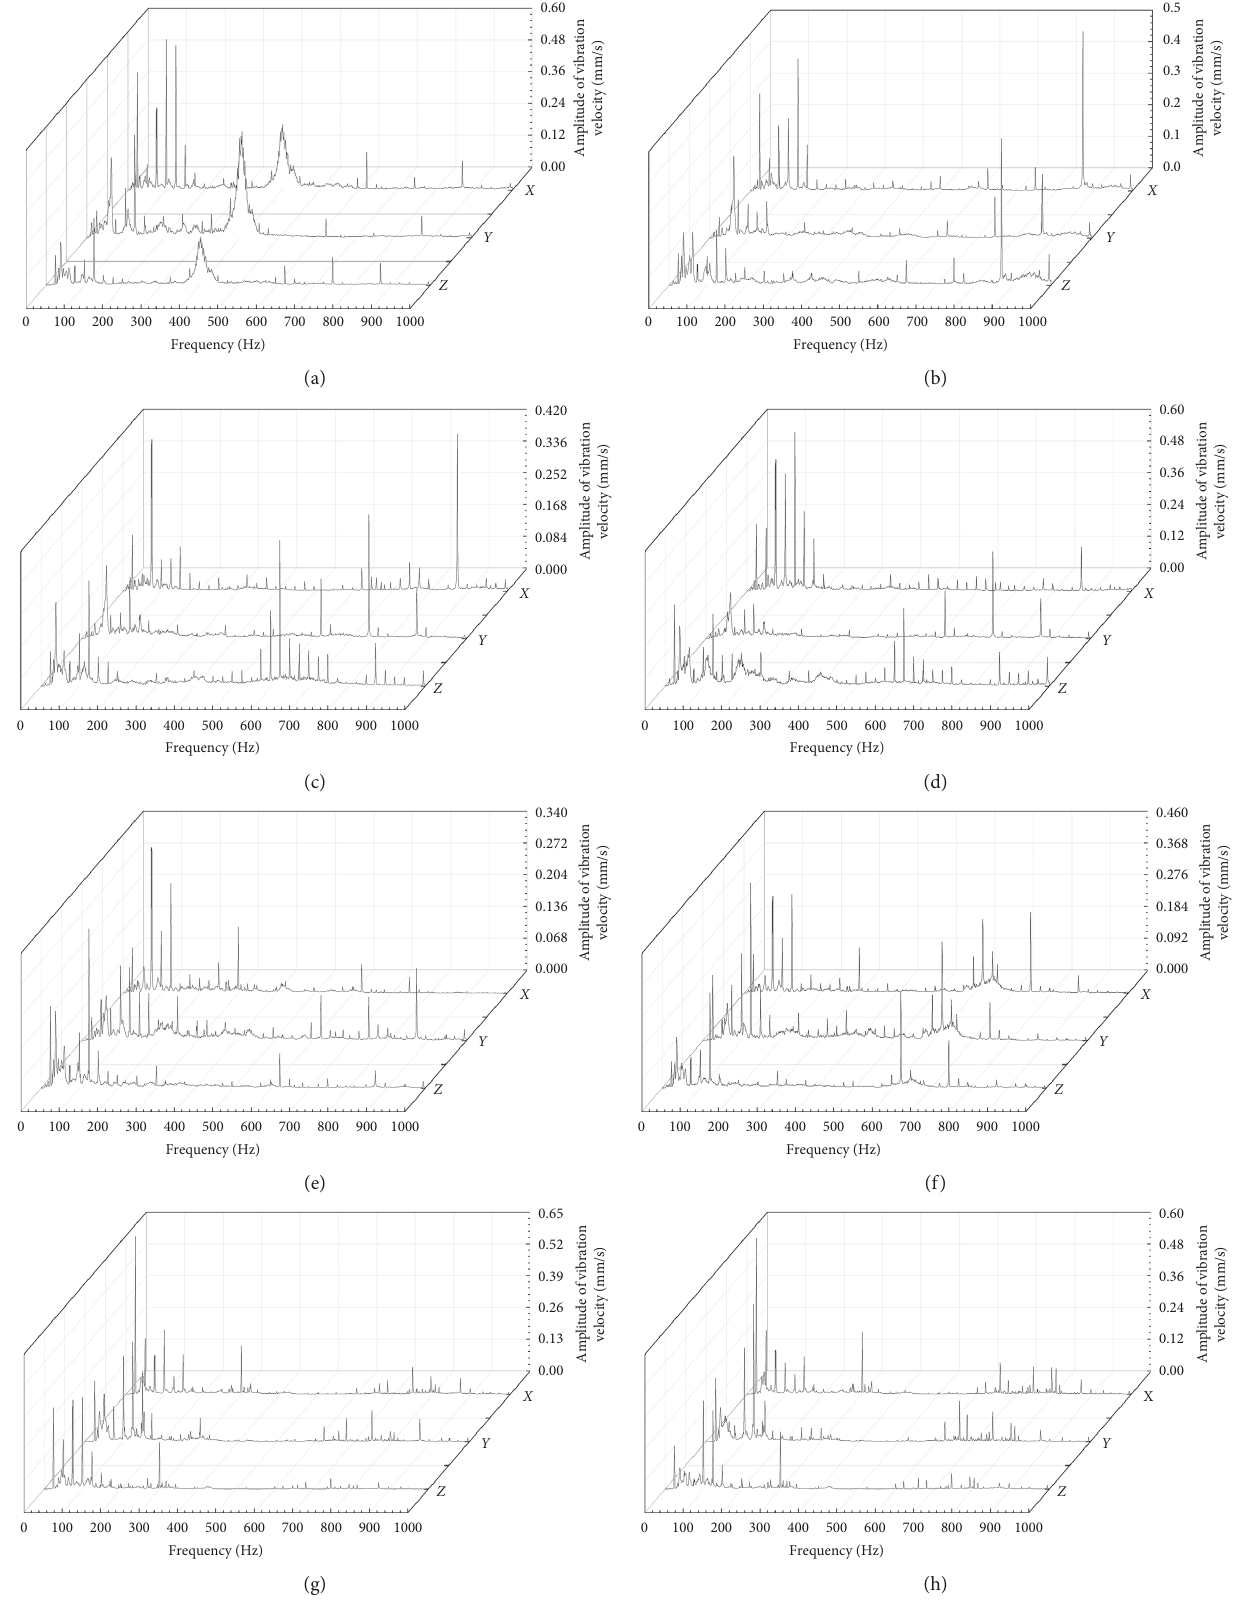
Figure 10: Frequency domain of vibration in the X , Y , and Z direction at (a) M1, (b) M2, (c) M3, (d) M4, (e) M5, (f) M6, (g) M7, and (h)